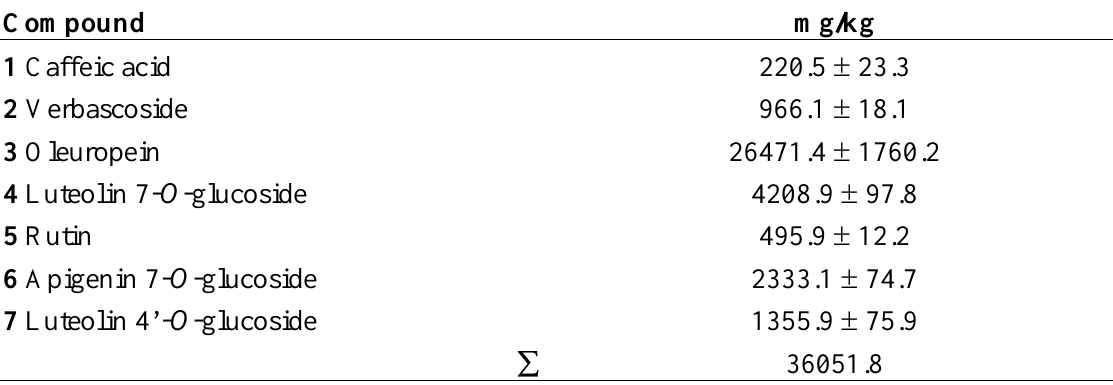
Table 1. Quantification of the phenolic compounds in olive leaf lyophilized extract. a